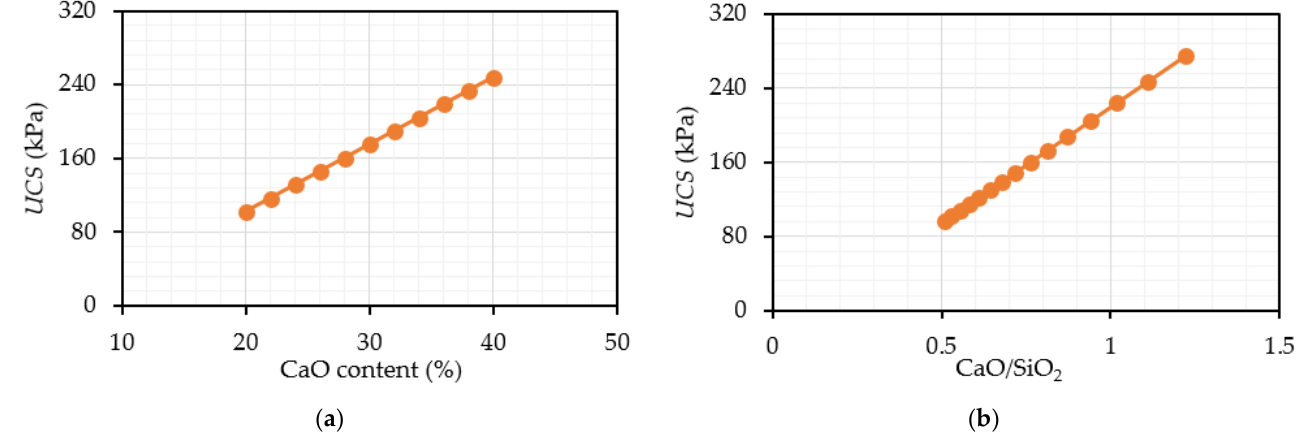
Figure 4. Effect of fly ash characteristics: ( a ) Effect of CaO content; ( b ) Effect of CaO/SiO 2.